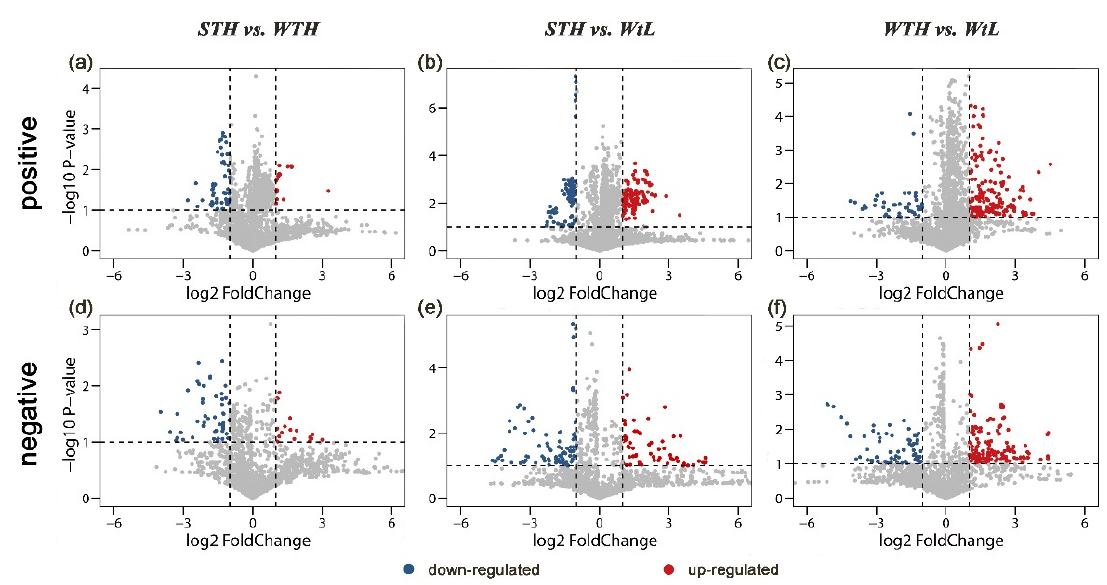
Figure 2. Volcano plots of uterine fluid collected from the STH, WTH, and WtL groups in the positive ( a – c ) and negative ( d – f ) ion modes. Red dots represent significantly upregulated metabolites, and blue dots represent significantly downregulated metabolites in the comparison group ( p < 0.05 and fold change ≥ 2). STH, hens with strong, thick, and heavy eggshells; WTH, hens with weak, thick, and heavy eggshells; and WtL, hens with weak, thin, and light eggshells.